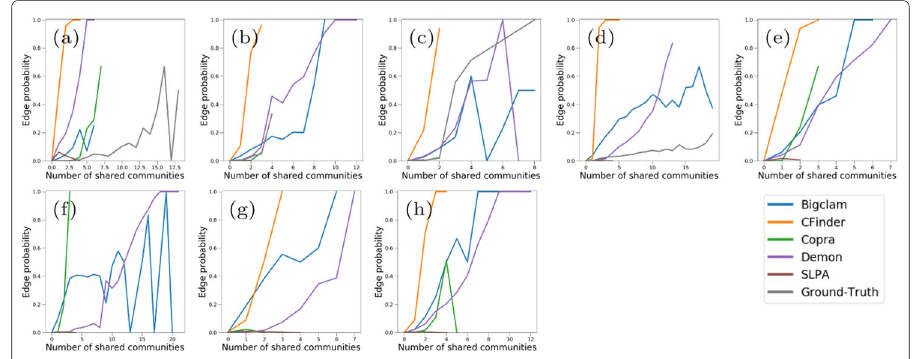
Fig. 31 Edge probability of the nodes identified by the methods considering the real-world networks: a Amazon; b DBLP; c LiveJournal; d Youtube; e CAGrQc; f CAHepPh; g Email; h